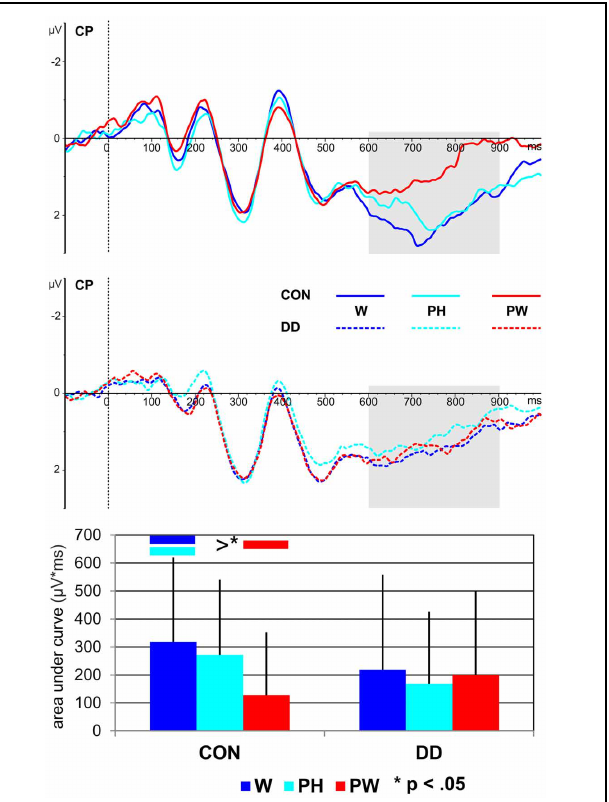
FIGURE 6 | Illustration of the averages across centro-parietal (CP) electrodes included in the ROI of the LPC for control children (CON) and children with DD (DD) and illustration of the mean area under the curve. W, words; PH, pseudohomophones; PW, pseudowords. The time window selected for the LPC is highlighted in gray (600–900 ms). Negativity is depicted upwards. Error bars illustrate standard deviations.